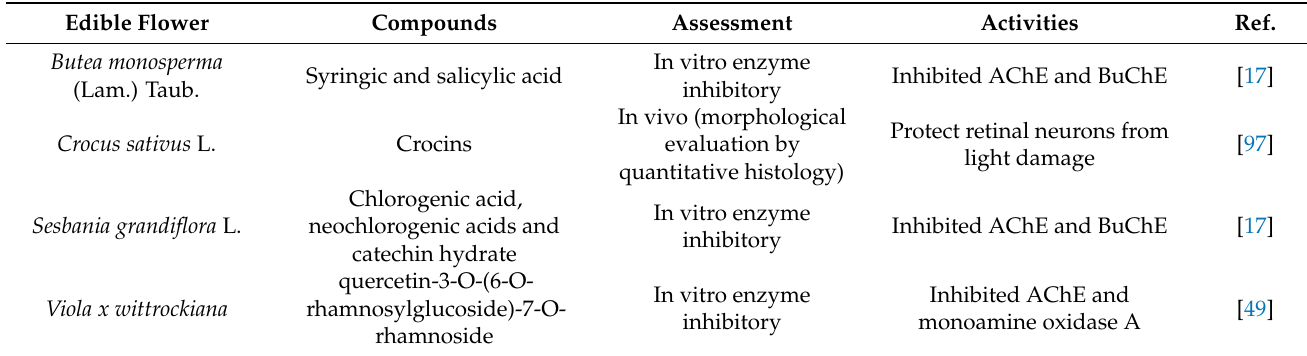
Table 6. Neuroprotective activities in edible